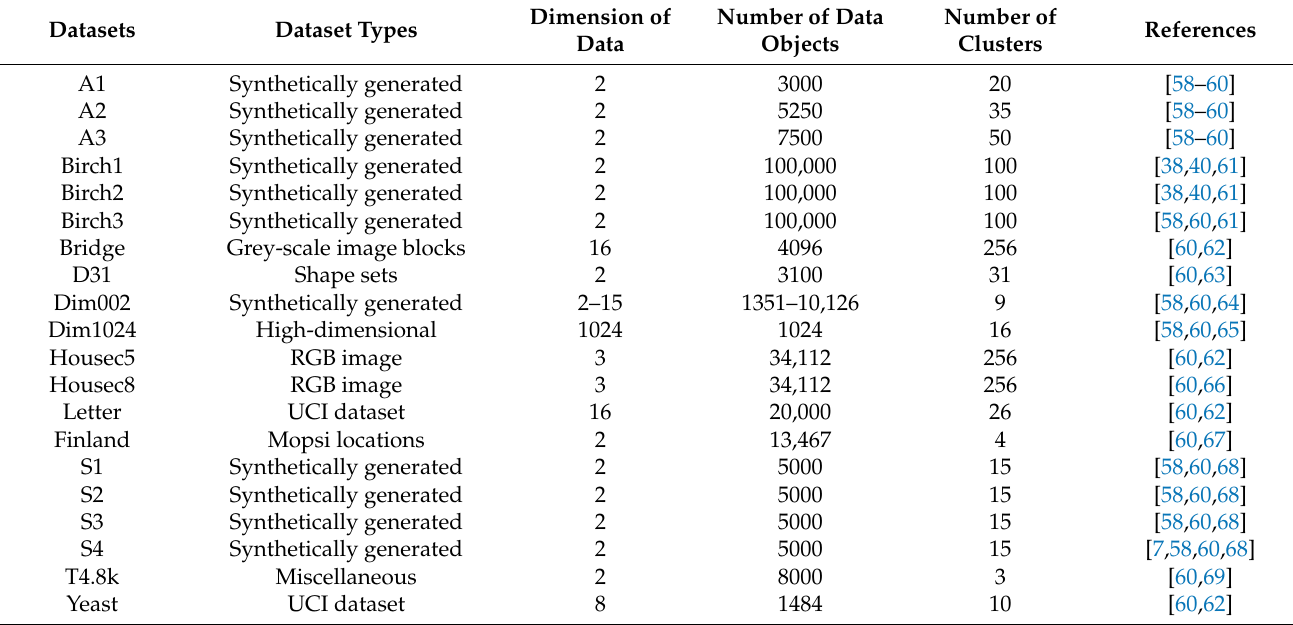
Table 2. The characteristics of twenty high-dimensional